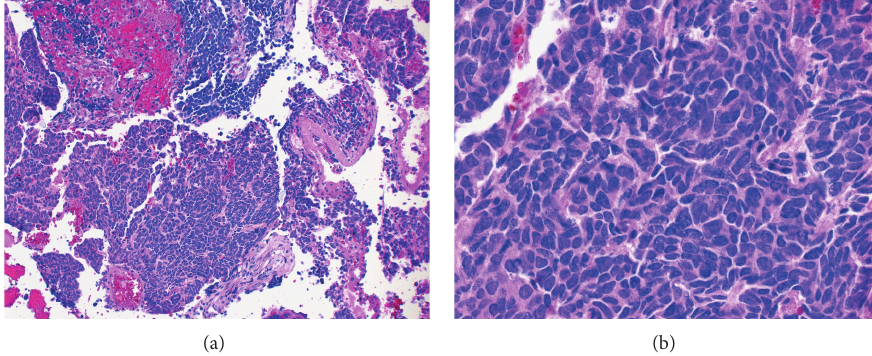
Figure 3: Pathology of the fragmented CPA tumor mass demonstrated poorly differentiated neuroendocrine carcinoma (small cell). (a) The tumor was highly cellular with tumor cells demonstrating a high nuclear to cytoplasmic ratio and molded nuclei (64x). (b) Higher magnification revealed characteristic finely granular, “salt and pepper” chromatin and frequent mitoses (254x). Both photomicrographs are of an H&E stained section. A Ki-67 proliferation index was high, and neoplastic cells were positive for cytokeratin, synaptophysin, and CD56 (not shown).